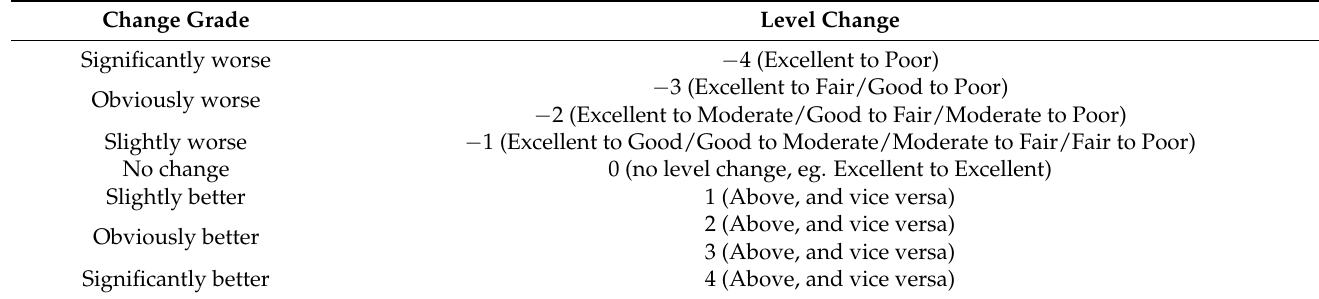
Table 7. Change in the ecological index grade.